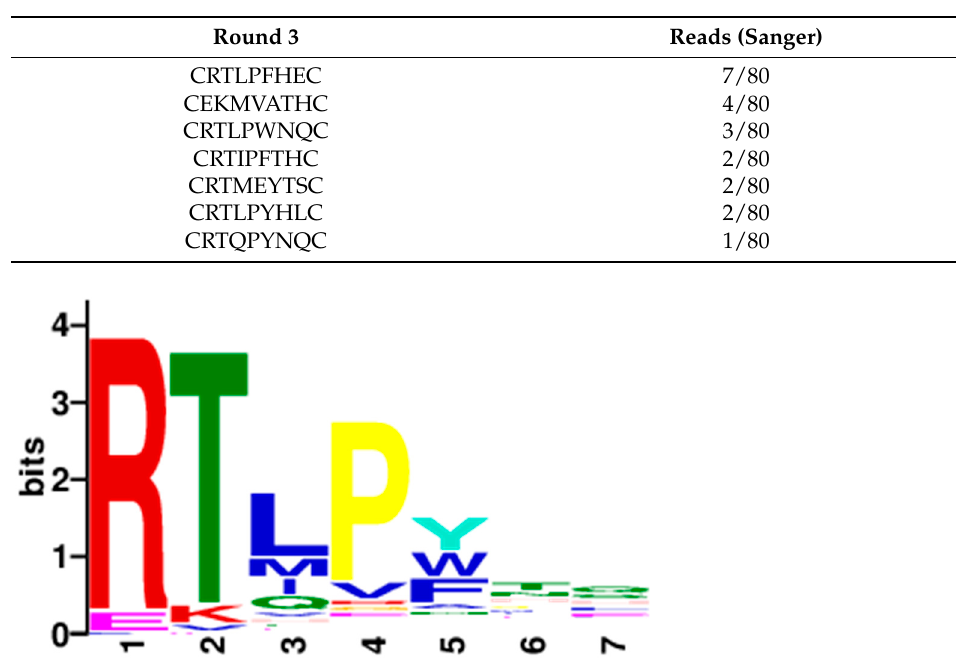
Table 2. Peptide sequences derived from the phage clones eluted after the third round of panning. The conserved similar and homologous amino acid residues between peptide sequences are marked with same colors. The frequency appears from high to low. The remaining parts are detailed in the appendix.